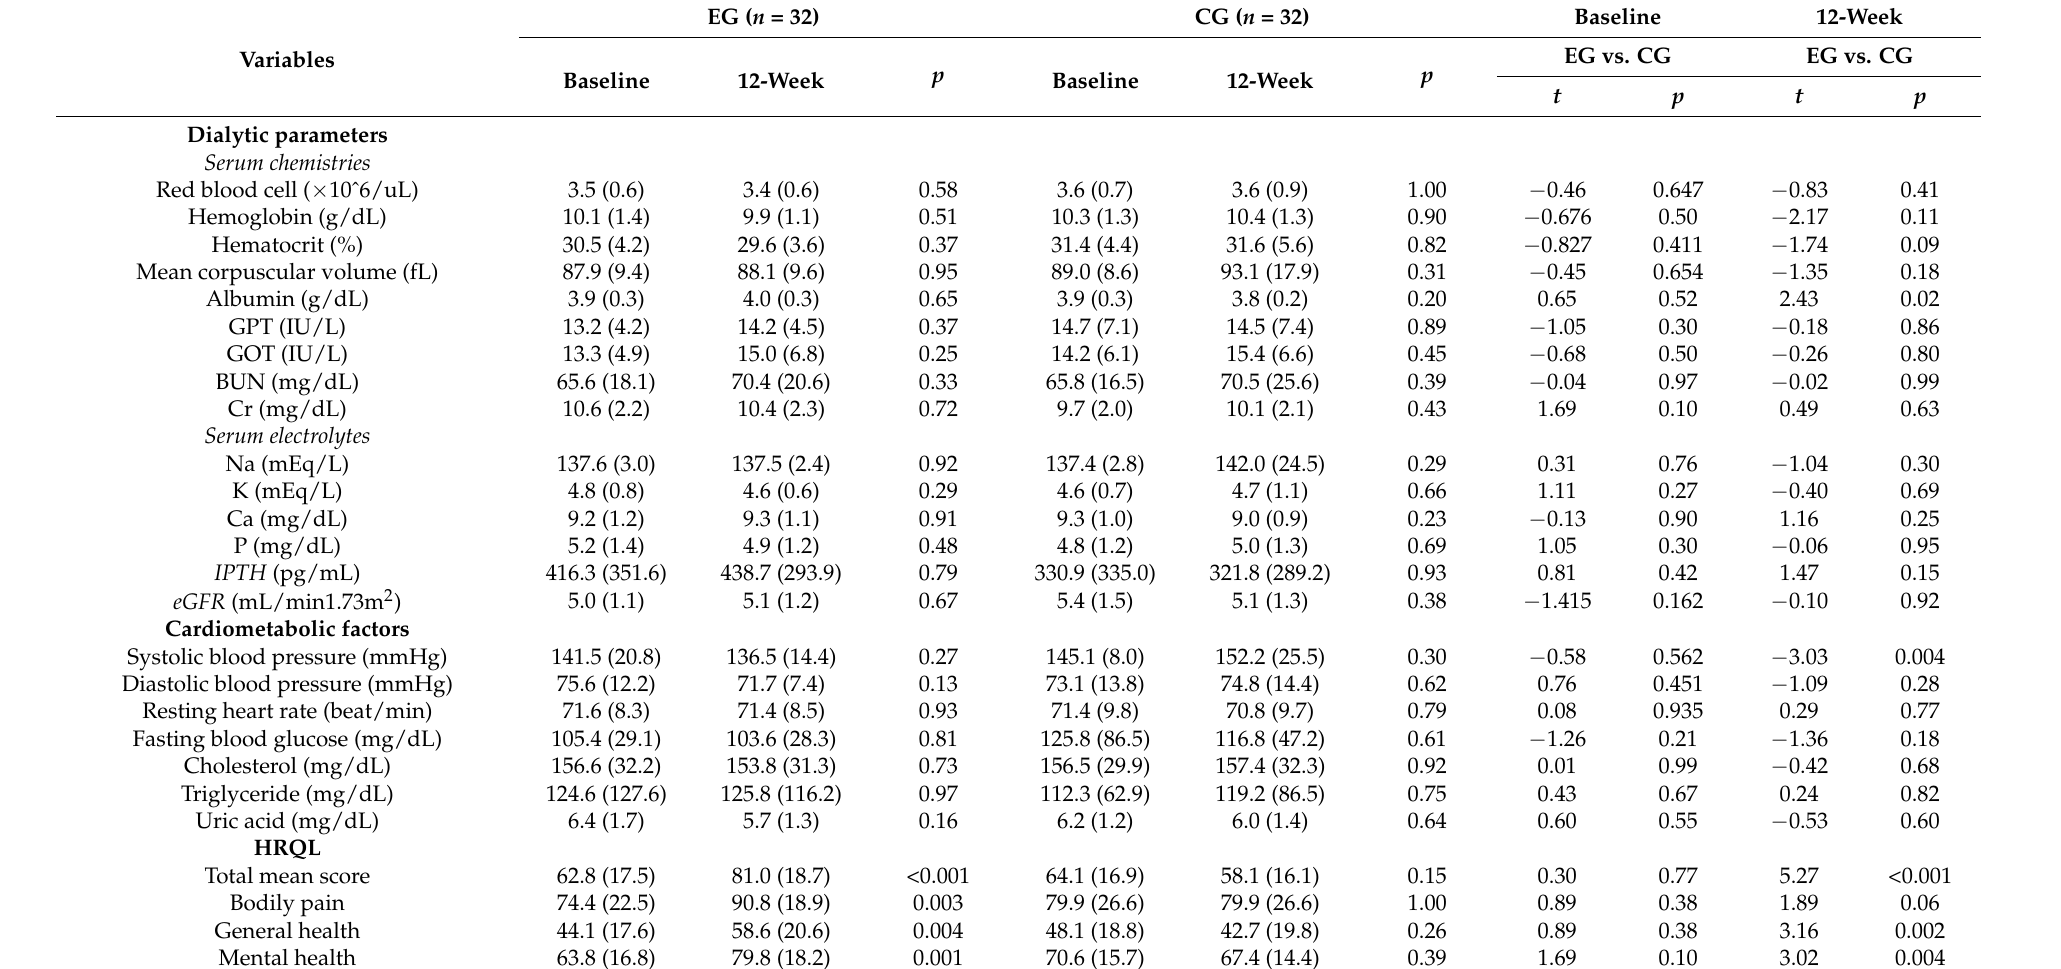
Table 2. Differences of outcome indicators between groups at baseline and after the